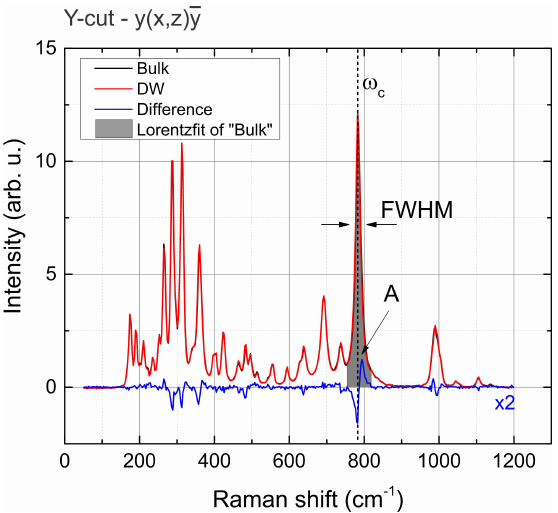
Figure 3. Raman images of the -z-surface of a periodically poled KTP sample based on the variation of intensity ( a ), FWHM ( b ) and peak wave numbers ( c ) of the 760 − 1 phonon mode highlighted in Figure 2.